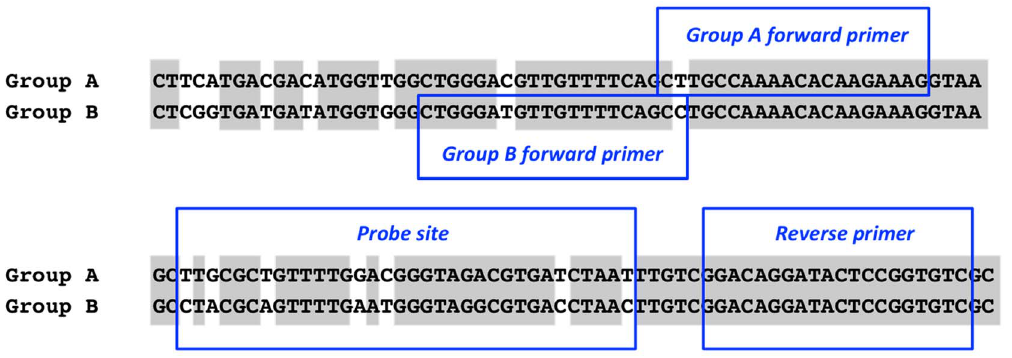
Figure 1. Placement of primers and probes used in real-time PCR. Part of the DNA lyase ( Apn2 ) nucleotide sequence used as the template for real-time PCR assay development. Shown is the placement of Colletotrichum cereale group-specific forward PCR primers A-Apn2-F, B-Apn2-F with probe sites for C. cereale clade A probe A-Apn2 and C. cereale clade B probe B-Apn2. Both sets of forward primers and probes utilized the same reverse primer, Apn2-R. Species-specific SNPs that differentiate target lineages are denoted by grey and white shading. Probe binding sites differed between the two clades by seven SNPs.